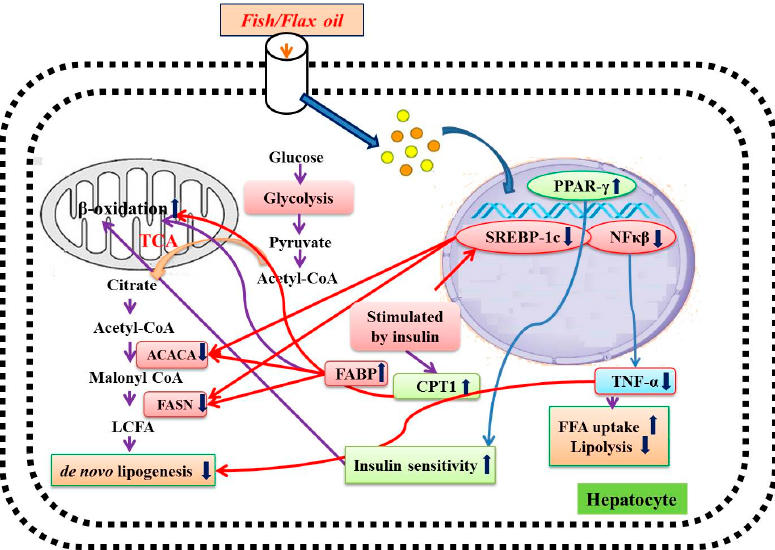
Figure 14. Mechanism of action of flax and fish oil intervention. PPAR- γ : Peroxisome proliferator-activated receptor gamma, SREBP-1c: Sterol regulatory element-binding proteins-1c, NF κβ : Nuclear factor- κβ , ACACA: Acetyl-CoA carboxylase alpha, FASN: Fatty acid synthase, CPT1: Carnitine palmitoyl transferase 1, FABP: Fatty-acid-binding proteins, TNF- α : Tumor necrosis factor-alpha,